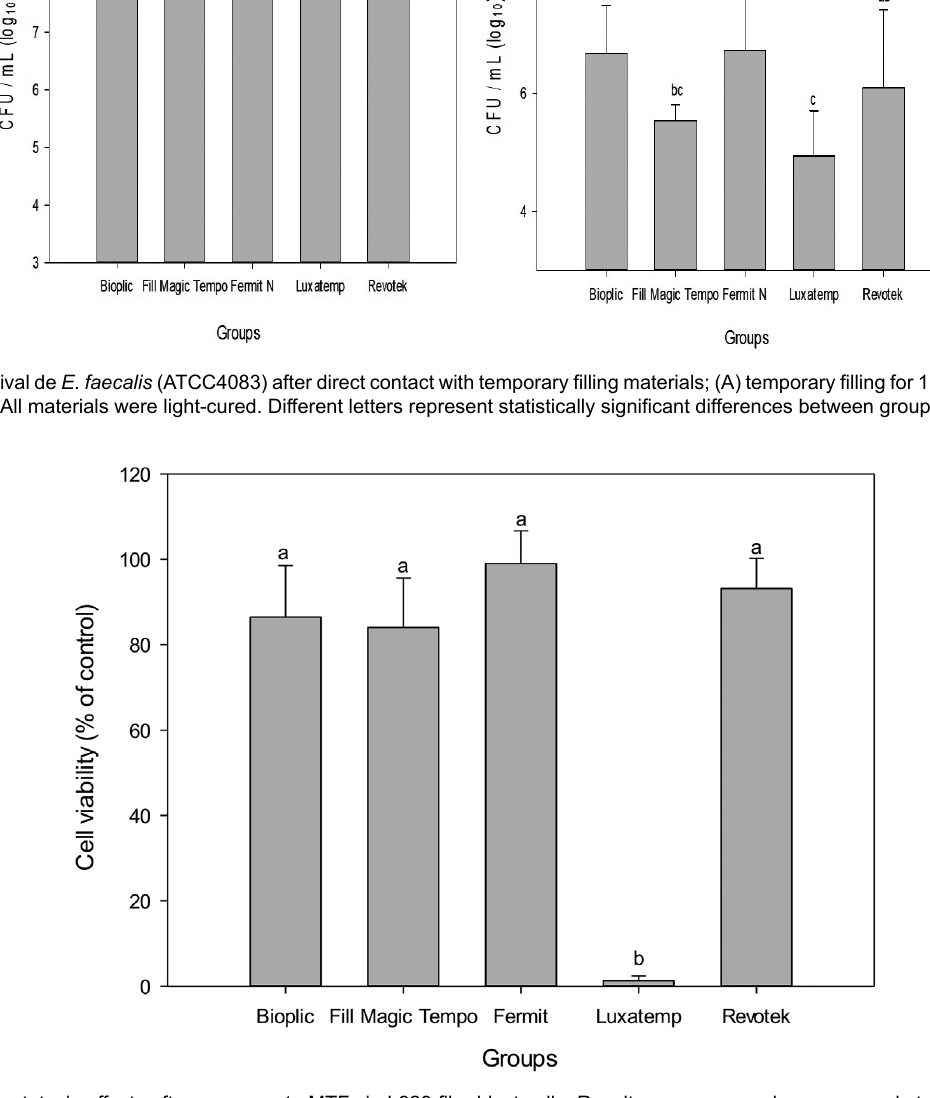
Figure 5- The cytotoxic effects after exposure to MTFs in L929 fibroblast cells. Results are expressed as mean and standard deviation. Different letters indicate statistically significant differences